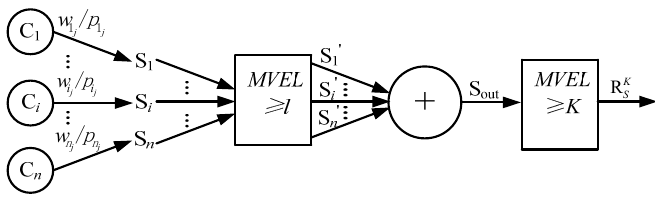
Figure 4. The stochastic multi-valued model for a multi-state weighted k -out-of- n system consisting of non-repairable components.